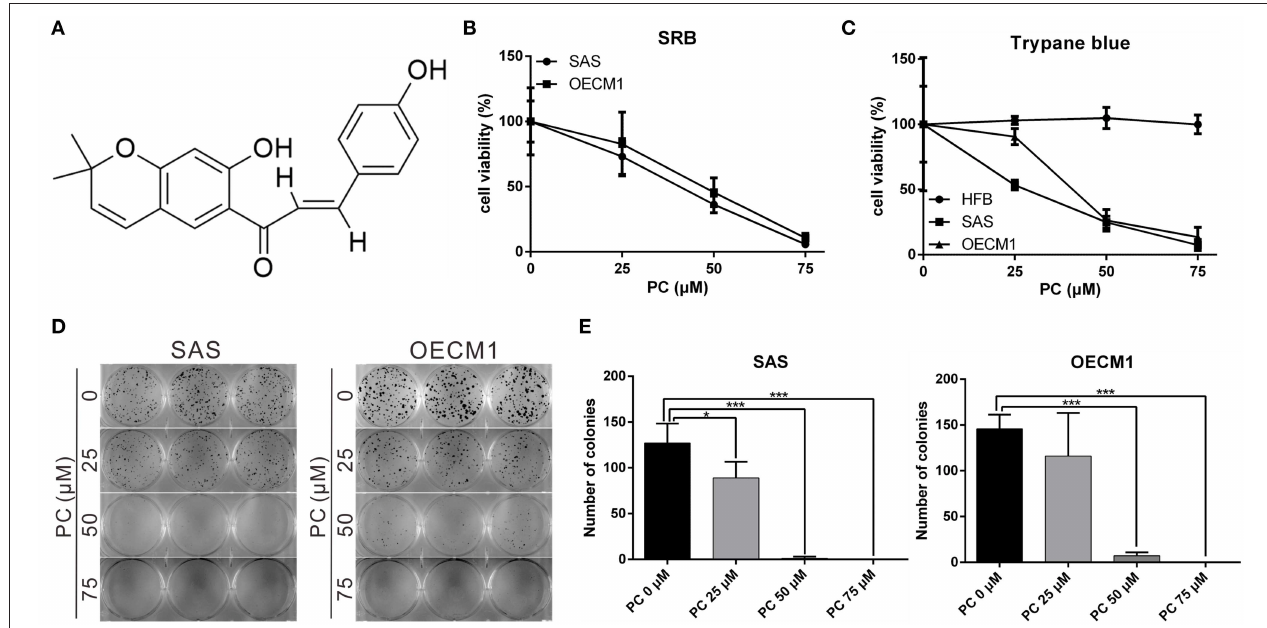
FIGURE 1 | Inhibition of the proliferation of OSCC cells by psorachromene. (A) Chemical structure of psorachromene. SAS and OECM1 cells were treated with different concentrations of psorachromene or vehicle (DMSO), and the cell proliferation status was analyzed using the SRB assay (B) , trypan blue staining assay (C) , and colony formation assay (D,E) . The results are the mean of three independent experiments. Significant differences vs. the control groups, * p < 0.05, *** p < 0.001.